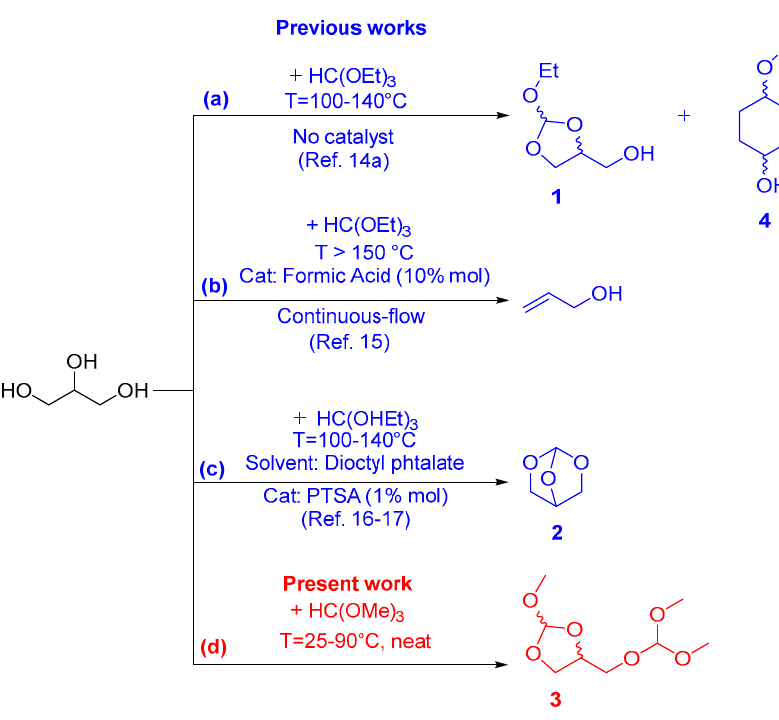
Figure 2. Reactions between Gly and OEs.